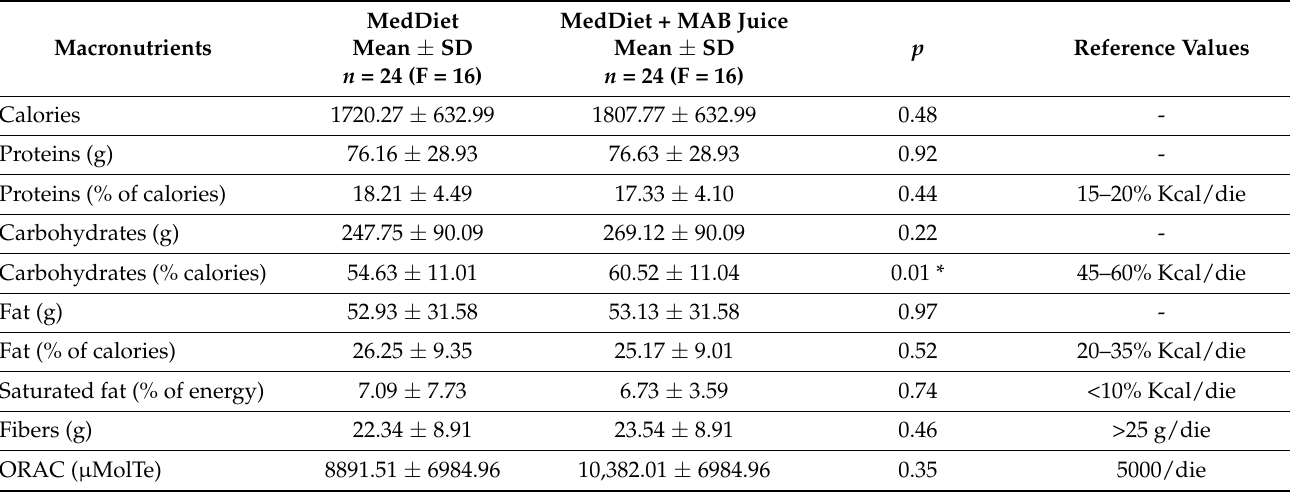
Table 2. Comparison between macronutrient intake and total antioxidant capacity of MedDiet and MedDiet + MAB juice.